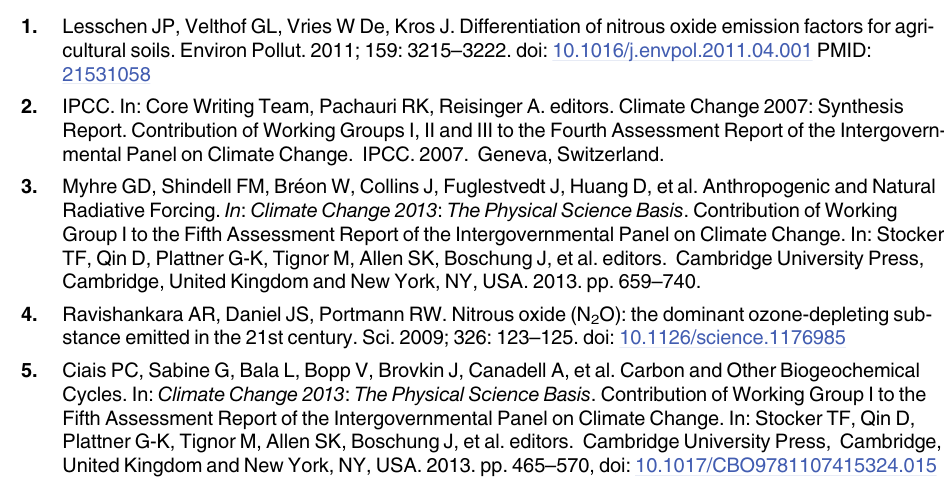
O production index ( I N 2